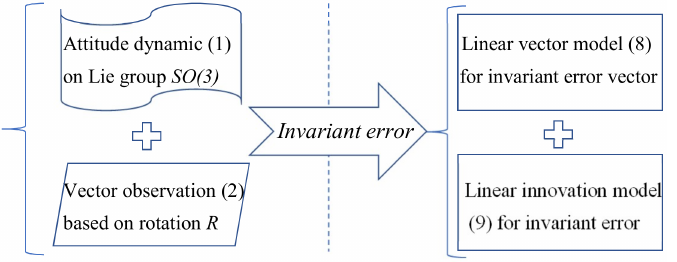
Figure 3. Projecting the Lie groups model into vector space based on the invariant